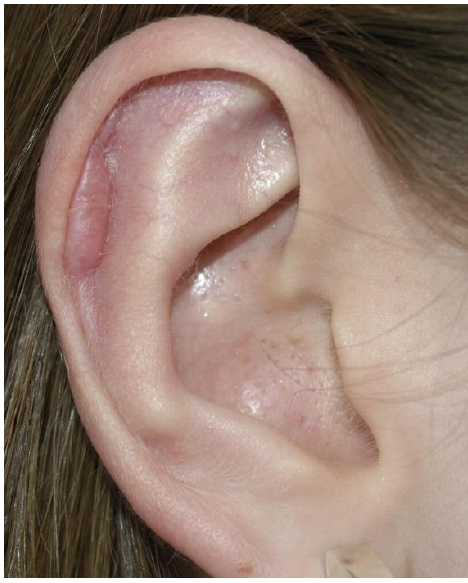
Figure 4. Hypertrophic scar after ventral approach.